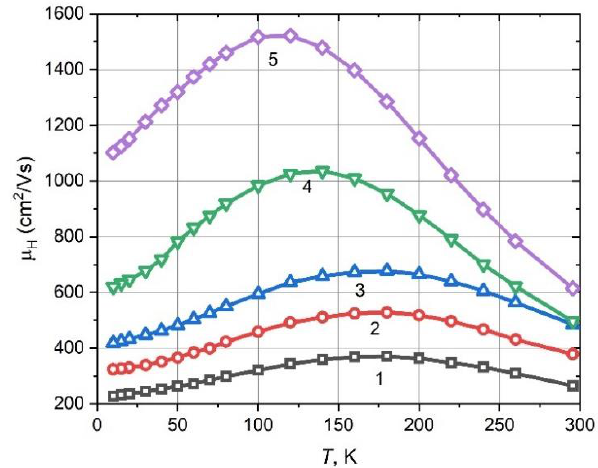
Figure 5. Experimentally obtained temperature dependence of the Hall mobility µ H of Pb 0.99 In 0.01 Te for various substrate temperatures. Numbers correspond to different substrate temperatures: 1 — 523 K, 2 — 548 K, 3 — 573 K, 4 — 598 K, 5 — 638 K.